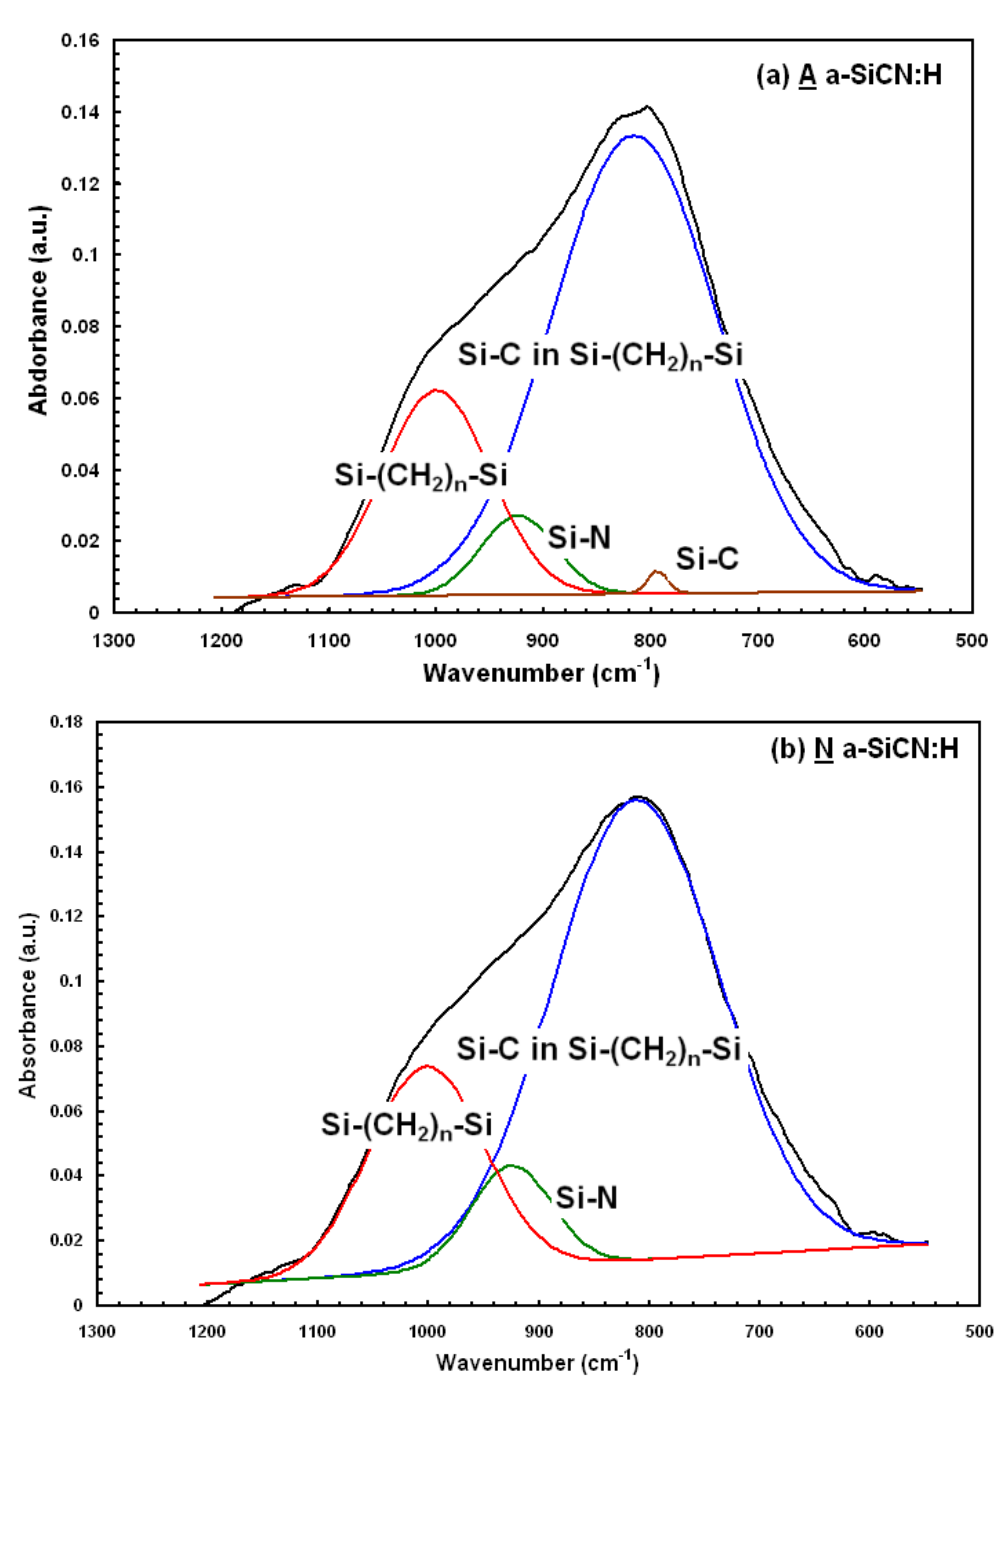
Figure 3. FTIR spectra of α -SiCN:H ( a ) A α -SiCN:H and ( b ) N α -SiCN:H films, which can be split into three peaks, corresponding to Si-C, Si-N, and Si-(CH ) -Si, 2 n